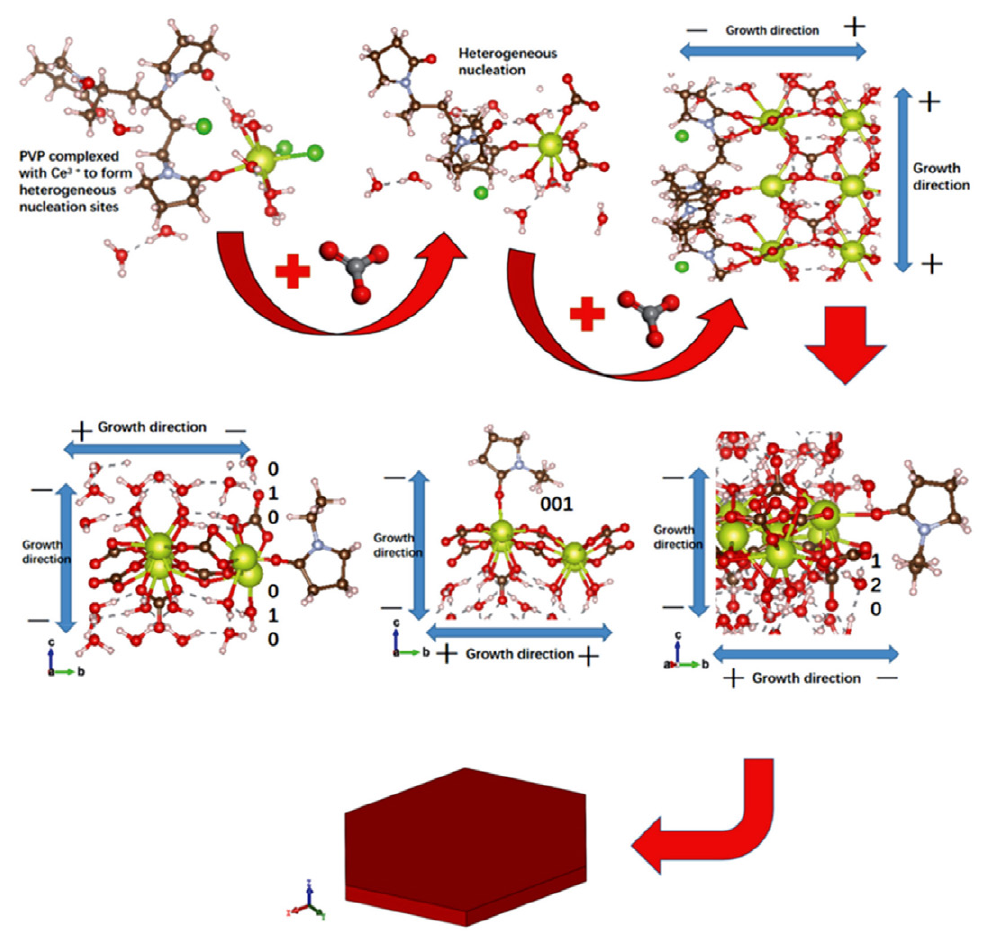
Figure 10. Process diagram of PVP regulating cerium carbonate crystal